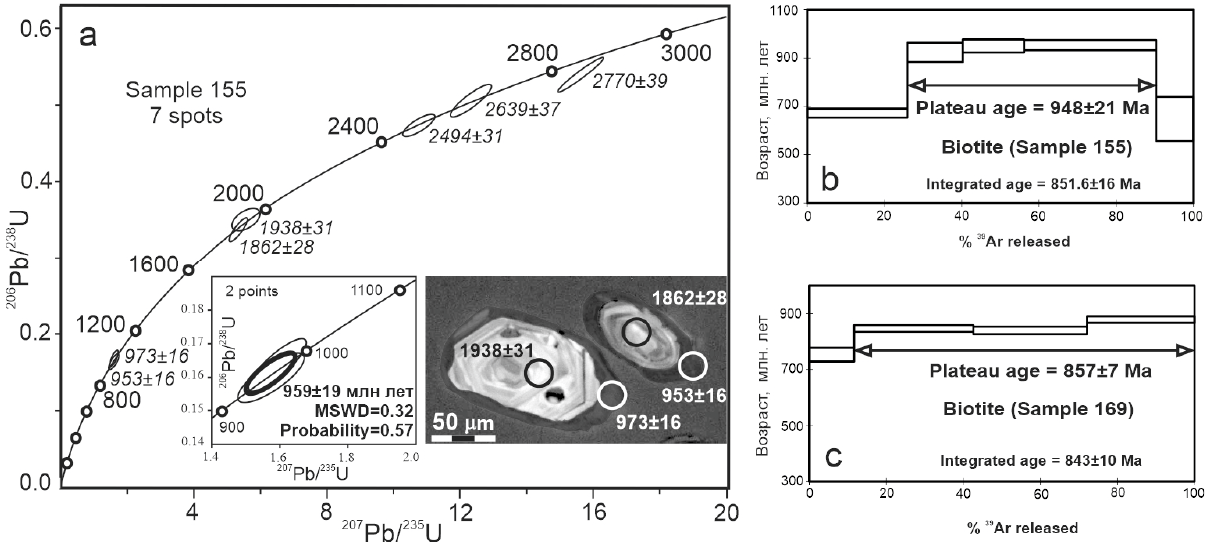
Figure 30. ( a ) Zircon U–Pb concordia diagram for LP/HT metapelites of the Teya area (sample 155) and representative CL zircon images with the age of the dated grains; ( b ) 40 Ar 39 Ar biotite ages for samples of LP/HT (sample 155) and ( c ) contact (sample 169) metapelites. The plateau (arrows) or integrated age is given for each sample. Sample locations are shown in Figure 10.